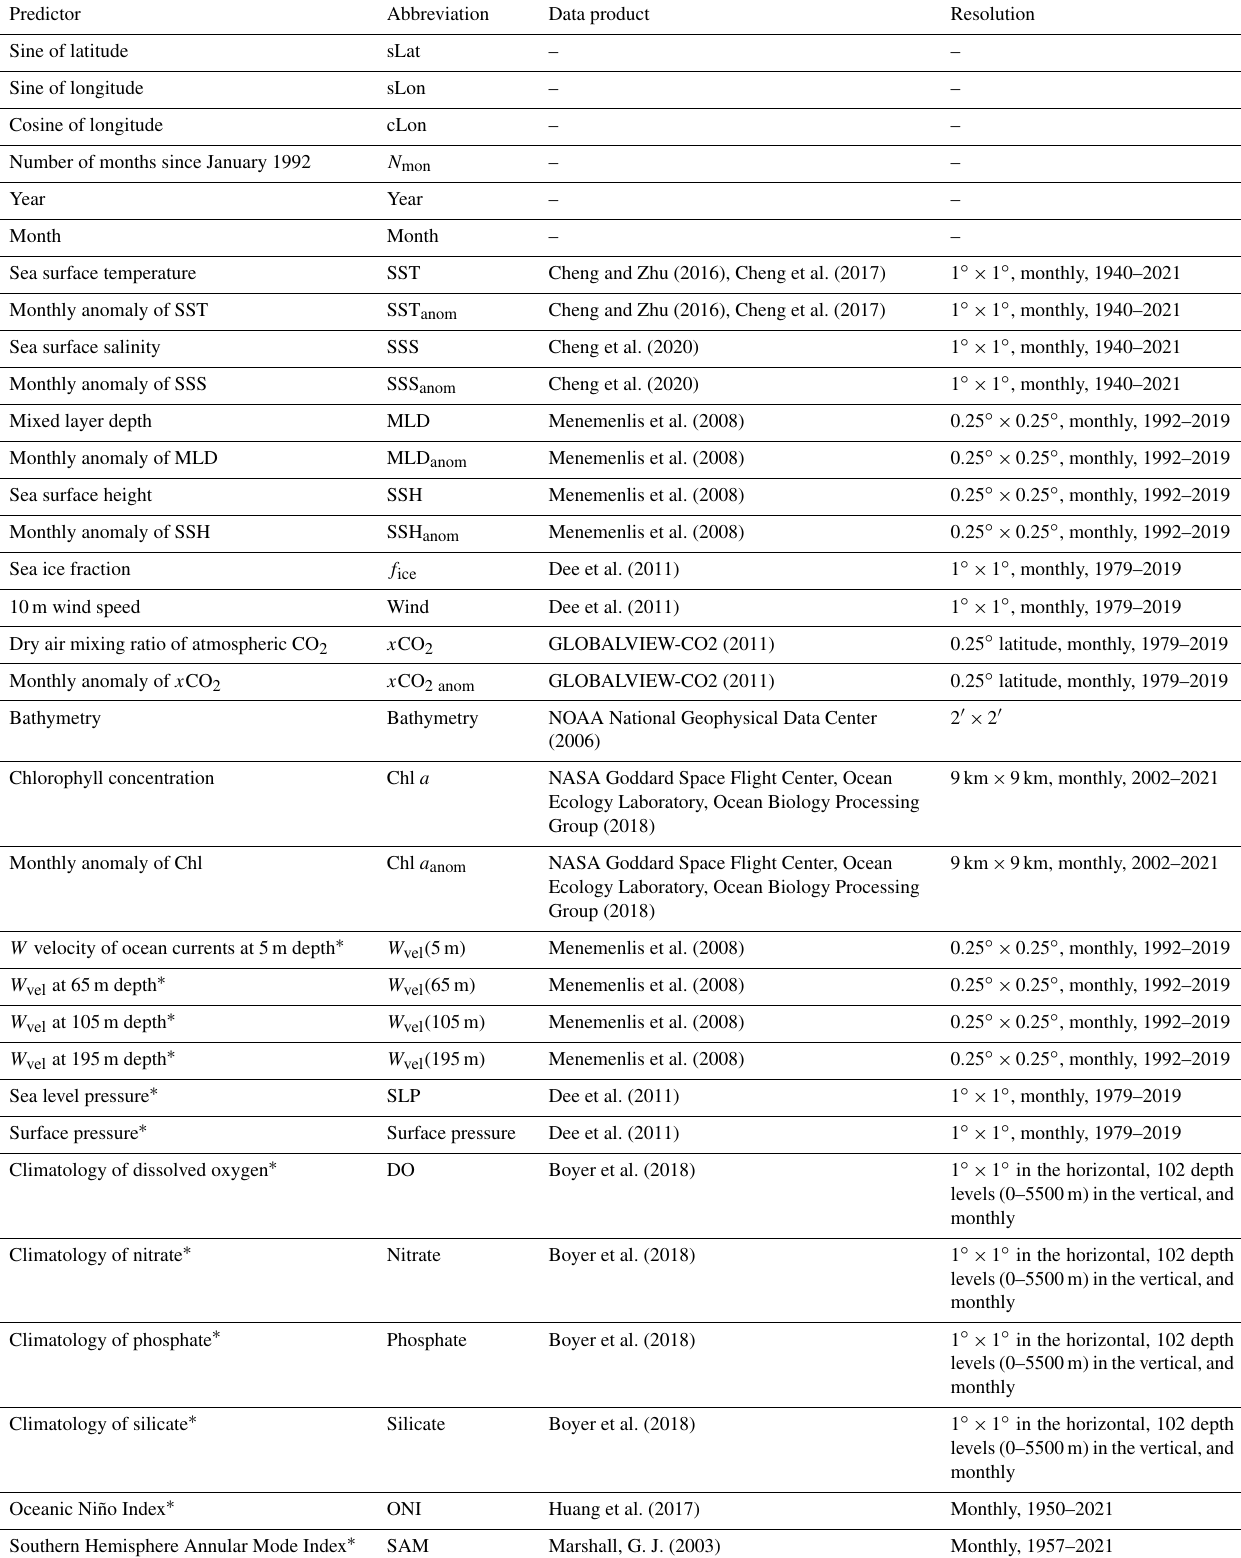
Table 1. Predictors and corresponding data